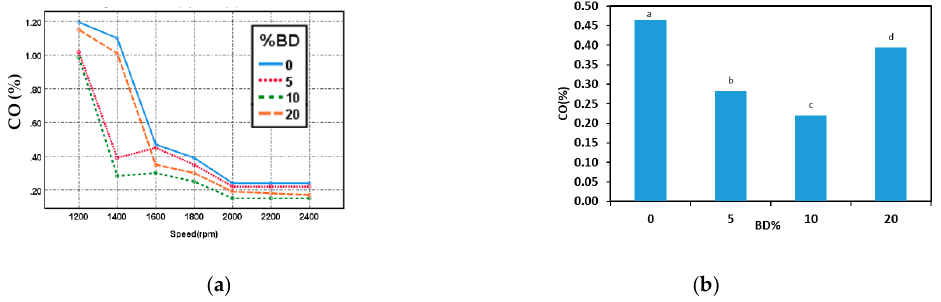
Figure 10. ( a ) CO vs. S at 100% load; ( b ) mean values of total data of CO for different speeds and loads. The letters a-d inside the diagrams indicate significant differences ( P ≤ 0.05).